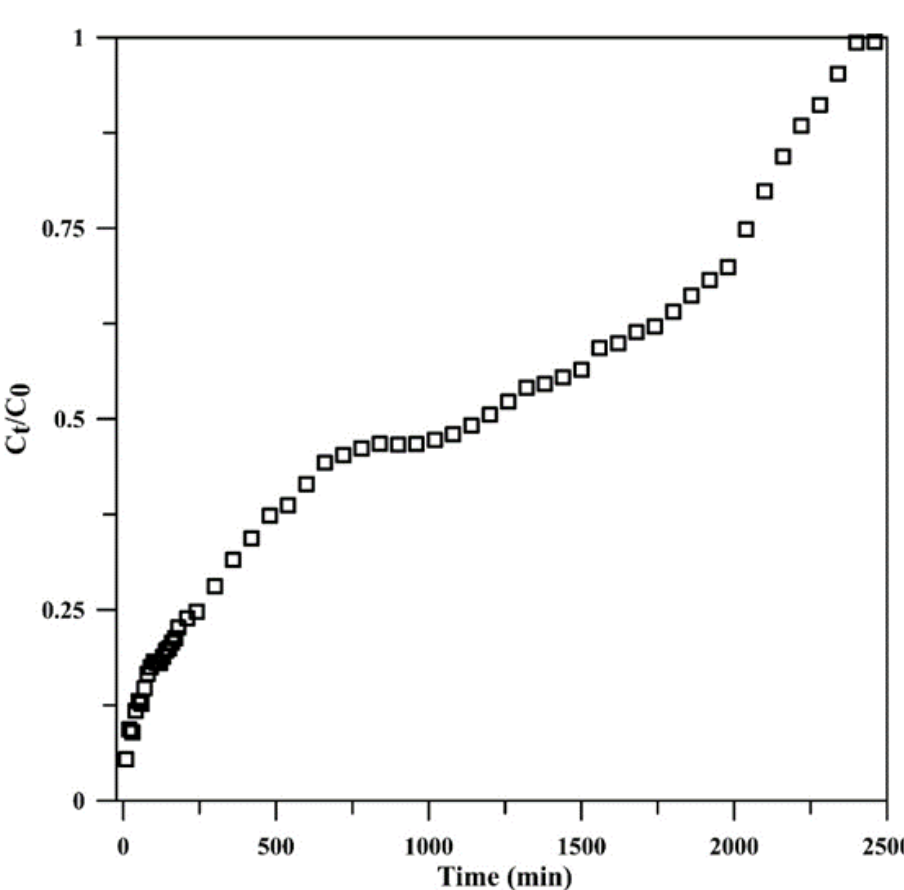
Figure 8. Breakthrough curve for phosphate adsorption by monolithic Cry–CSH using a real sample.